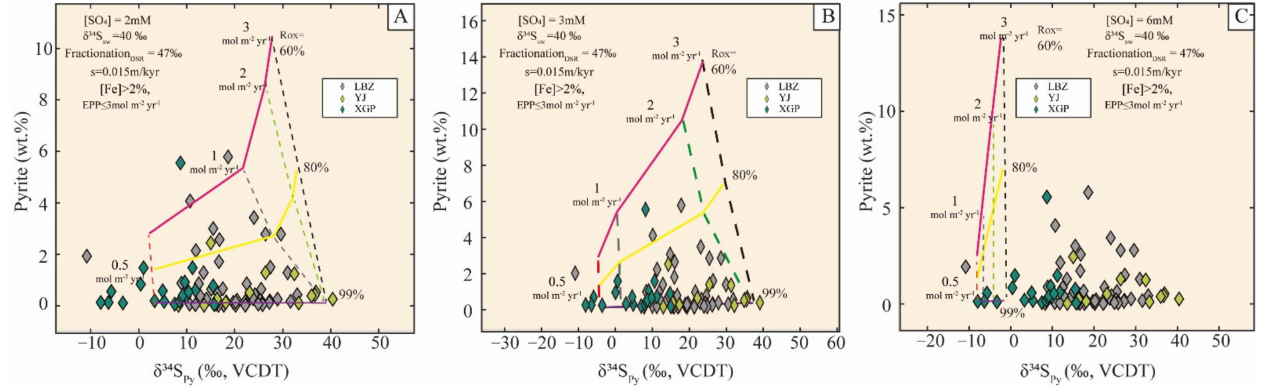
Figure 6. Modeling results of sulfate concentrations during the E–C transition in deep water. ( A ) Mod- eling results showing 2 mM in shallow water. ( B ) Modeling results showing 4 mM in shallow water. ( C ) Modeling results showing 6 mM in shallow water. In the figures, the horizontal axis represents the pyrite sulfur isotopic composition, and the vertical axis indicates the pyrite content. The pink, yellow, and purple solid lines indicate that the proportion of H 2 S reoxidation was 60%, 80%, and 99%, respectively. The orange, gray, green, and black dashed lines indicate that the organic matter flux was 0.1, 1, 2, and 3 mol/m 2 /yr, respectively. The boundary conditions of the model are shown in